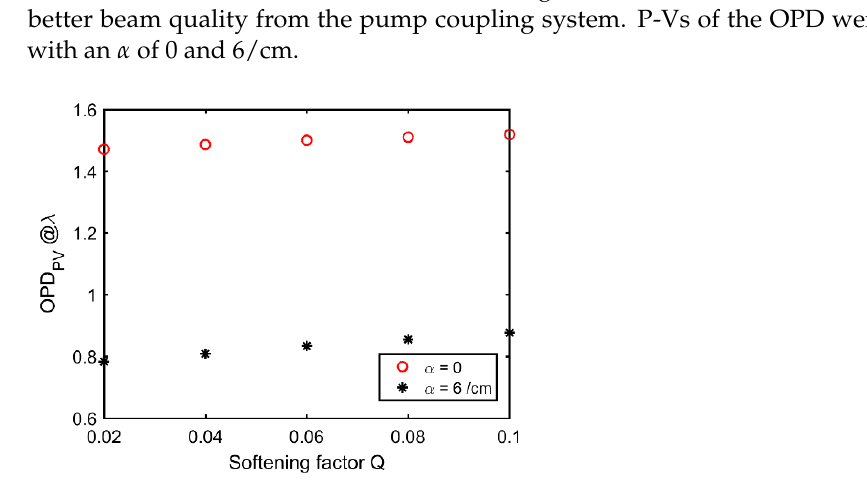
Figure 10. Peak-to-valley (P-V) of the OPD for a single slab as a function of Q with two absorption coefficients: α = 0 (red) and α = 6/cm (black).